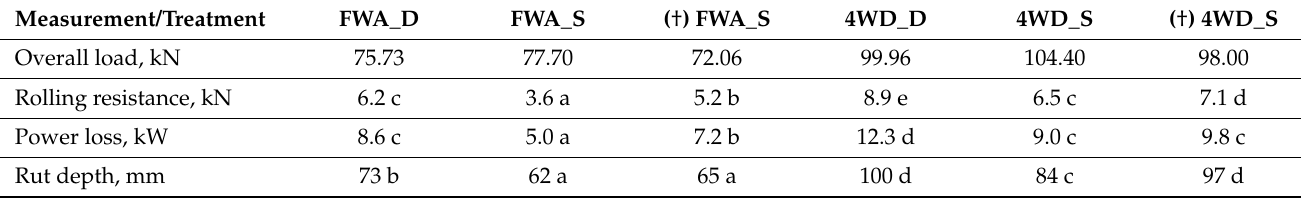
Table 4. Rolling resistance, rut depth, and power losses recorded for the FWA and 4WD tractors after single-pass tests. Different letters (horizontally) indicate that mean values are significantly different ( p < 0.05). Description of the tractors and treatments’ notation are as shown in the caption of Table